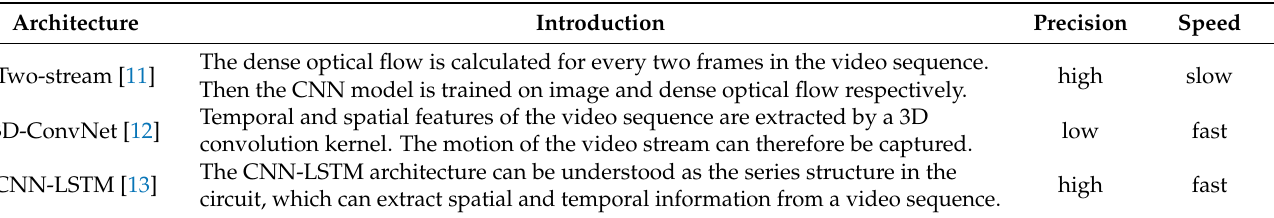
Table 1. Comparison of mainstream architectures in the field of